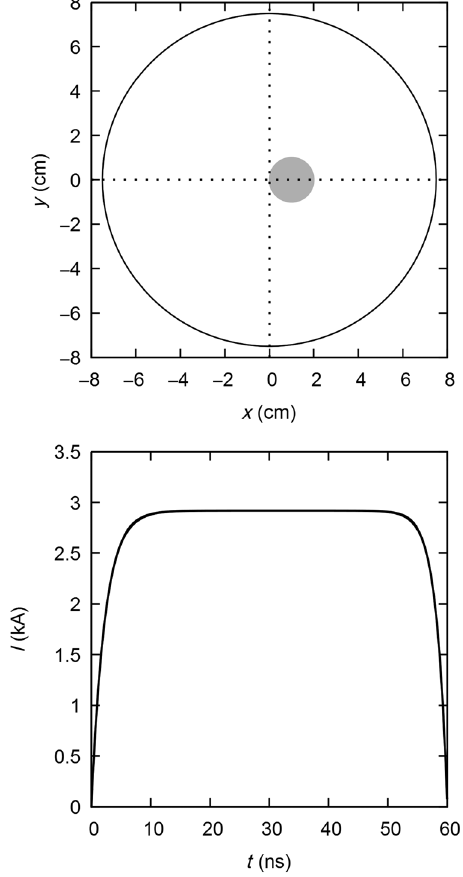
FIG. 4. Top: injected beam current density profile for 3D cylindrical CHICAGO beam deflection simulation. The beam is injected into the pipe ( b ¼ 7 . 5 cm) at z ¼ − 60 cm. An ideal pillbox gap is centered at z ¼ 0 with d ¼ 2 . 5 cm, R ¼ 27 cm, and Z z =Z o ¼ 4 . Bottom: injected beam current as a function of